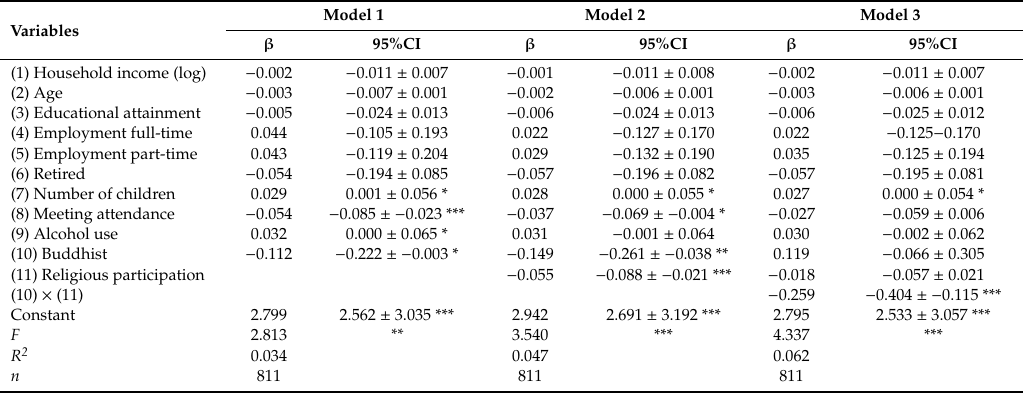
Table 2. OLS regression models to predict depressive